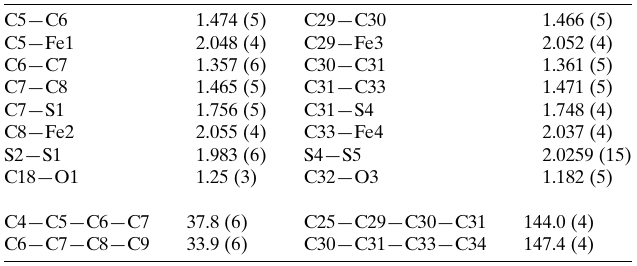
Table 3 Experimental details.